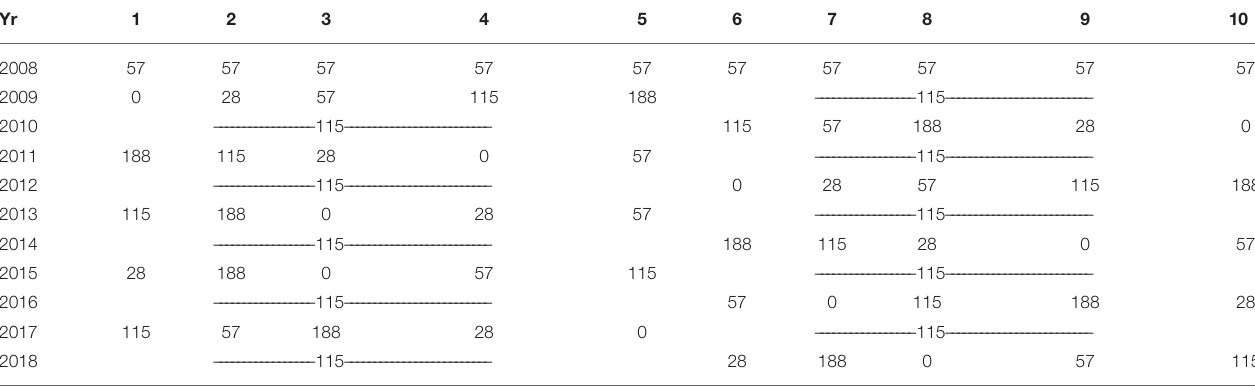
TABLE 1 | Experimental design for assessing the effects of nitrogen rate on corn yield and environmental losses during 2009–2018.